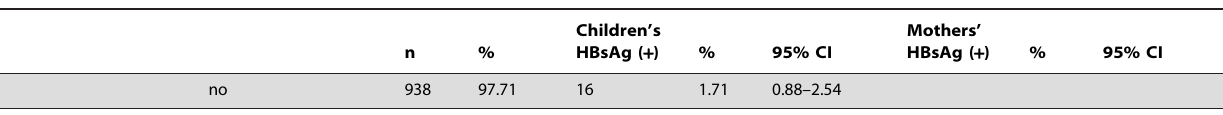
Table 2. HBsAg prevalence among children (5 to 9 years old) and mothers (15 to 45 years old).